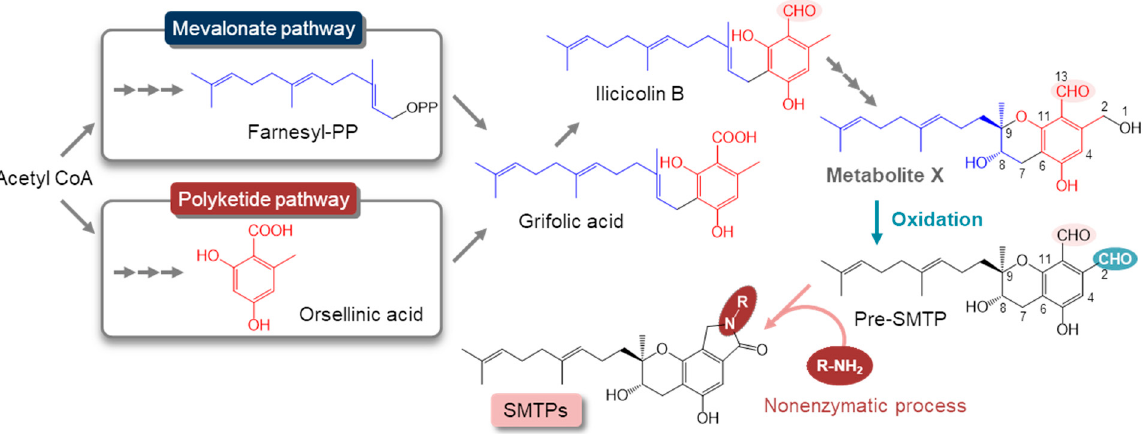
Figure 1. Putative pathway for the biosynthesis of SMTP. SMTP can originate from grifolic acid, which is derived from farnesyl pyrophosphate and orsellinic acid. Grifolic acid undergoes reduction to form ilicicolin B, which can derive pre-SMTP, which has an amine-reactive, aromatic ortho-dialdehyde function. A non-enzymatic reaction between pre-SMTP and a primary amine affords a variety of SMTP congeners that differ in the N -linked side chain. We hypothesize that pre-SMTP is formed via an enzymatic oxidation of the alcoholic function at position 1 of the speculative metabolite X.